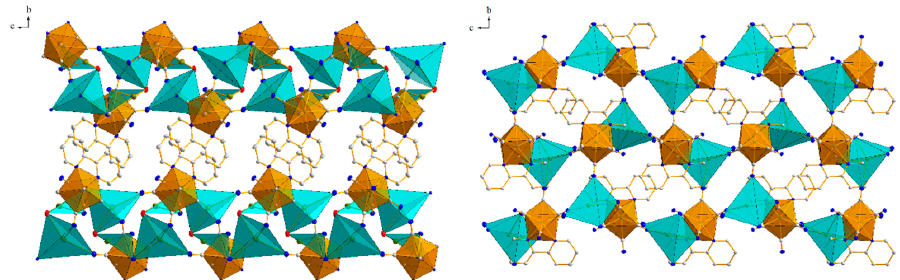
Figure 3. Packing diagrams in structure 1 ( left ) and 2 ( right ), both in projection in the (100) direction. The orange colour represents the coordination polyhedra of the tungsten W atoms, and the blue colour represents the thallium cations. Left: clearly visible layered packing character of structure 1 , also observed in all alkali analogues of [W IV (CN) 6 (bpy)] 2 − . Right: the characteristic 3D packing motif of structure 2 based on one [W V (CN) 6 (bpy)] − anion connected by cyanide bridges to one Tl(I) cation. 30% ellipsoidal probability; hydrogen atoms are omitted for